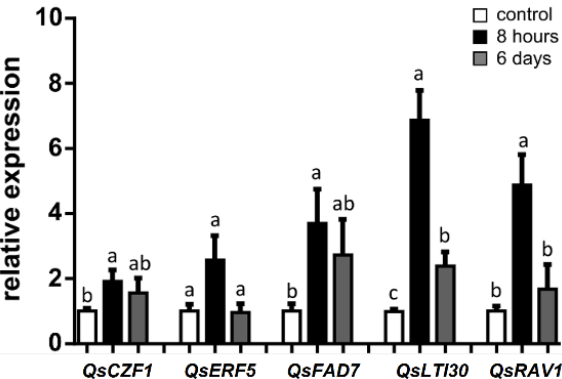
Figure 3. Relative expression levels of genes encoding stress biomarkers in Q. suber roots under control and salinity conditions (8 h and 6 days after 300 mM NaCl treatment). Values are mean ± SEM (n = 6). For each gene, different letters indicate significant differences between control and salinity treatments ( p < 0.05).